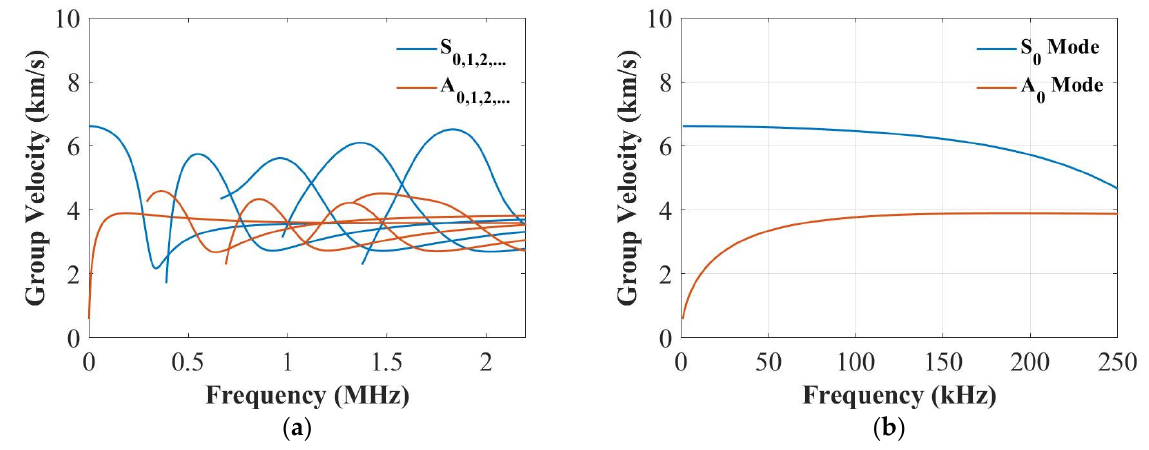
Figure 4. Dispersion curves for the group velocity from 0 to 2.5 MHz ( a ) and from 0 to 250 kHz ( b ) for the 9 mm thick panel.